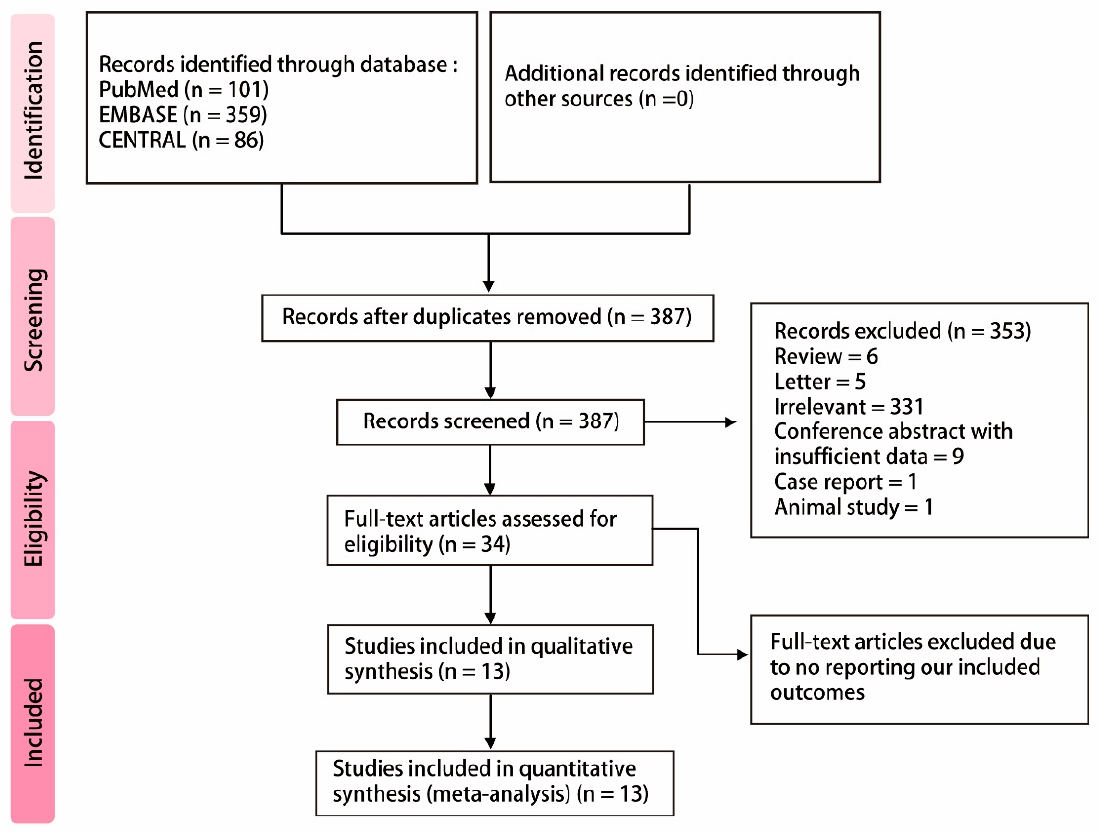
Figure 1. PRISMA flow diagram.